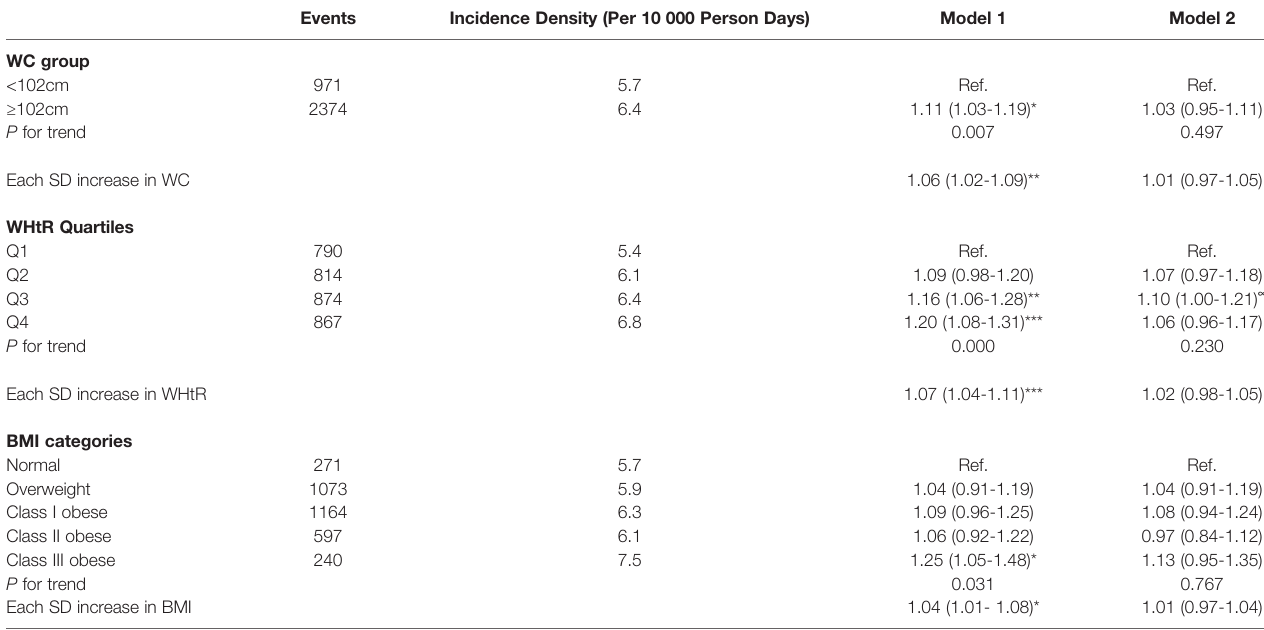
TABLE 2 | Hazard ratios for incident DN, by WC, WHtR, and BMI among men with diabetes (n=5,489).